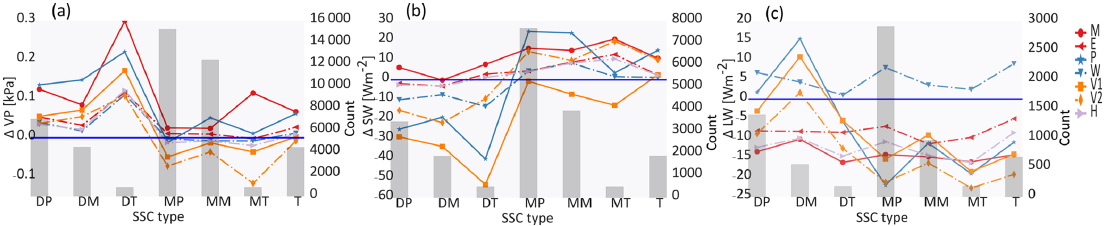
Figure 7. Differences between model estimates and observed values binned according to the daily air mass type, classified for nearby stations within Norway (Bower et al., 2007). The air mass types are dry polar (DP), dry moderate (DM), dry tropical (DT), moist polar (MP), moist moderate (MM), moist tropical (MT), and transitional (T). Panel (a) shows the mean difference in vapor pressure for Saerheim, Aas, Bergen, Bodø, Tromsø, and Maze stations. Panel (b) shows differences between model estimates and observed incident shortwave radiation at Saerheim (Sola airport), Aas (Fornebu airport), Bergen (Flesland airport), and Trondheim (Ørland airport). Panel (c) depicts differences in incident longwave radiation binned according to air mass type in Bergen (Flesland airport) and Trondheim (Ørland airport).